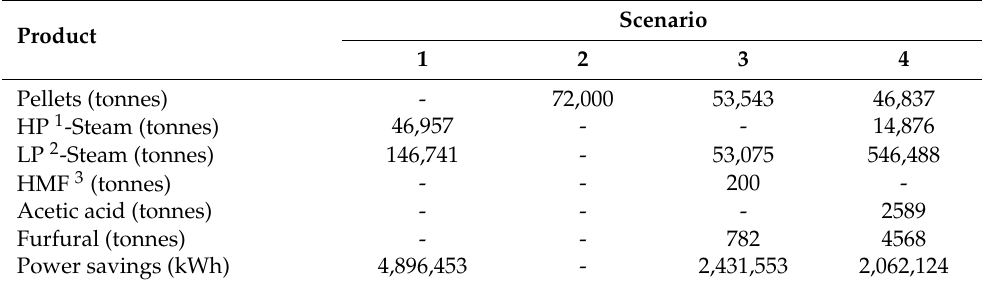
Table 3. The annual production rate of various products and power savings from each case